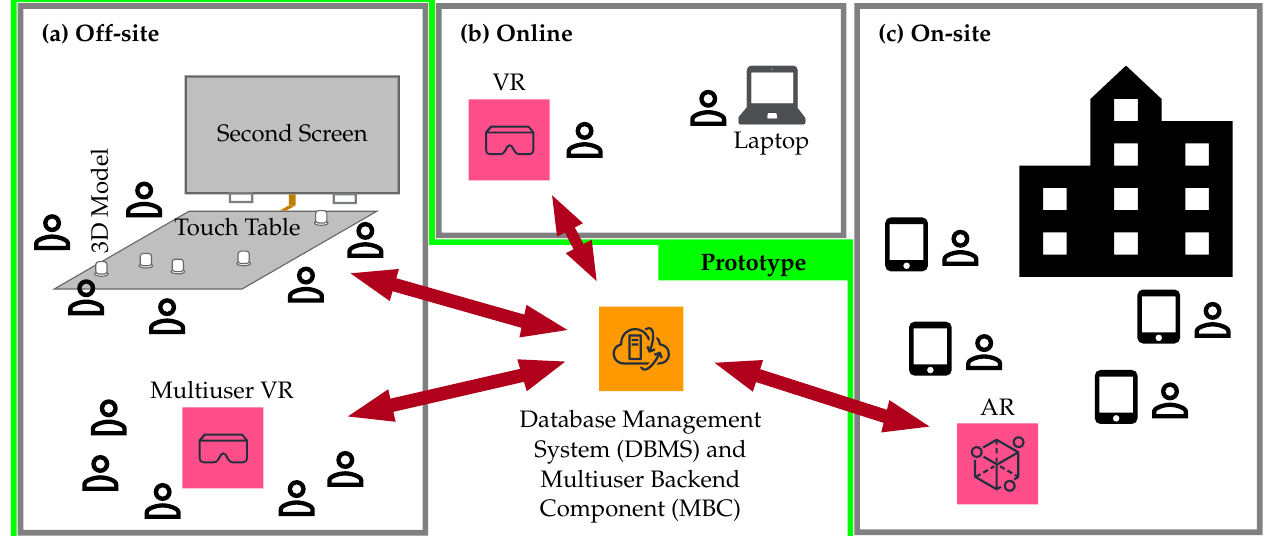
Figure 1. PaKOMM combines three participation approaches: Off-site (a), Online (b), and On-site (c) collaboration. [7] The green frame indicates the first prototype’s implementation.